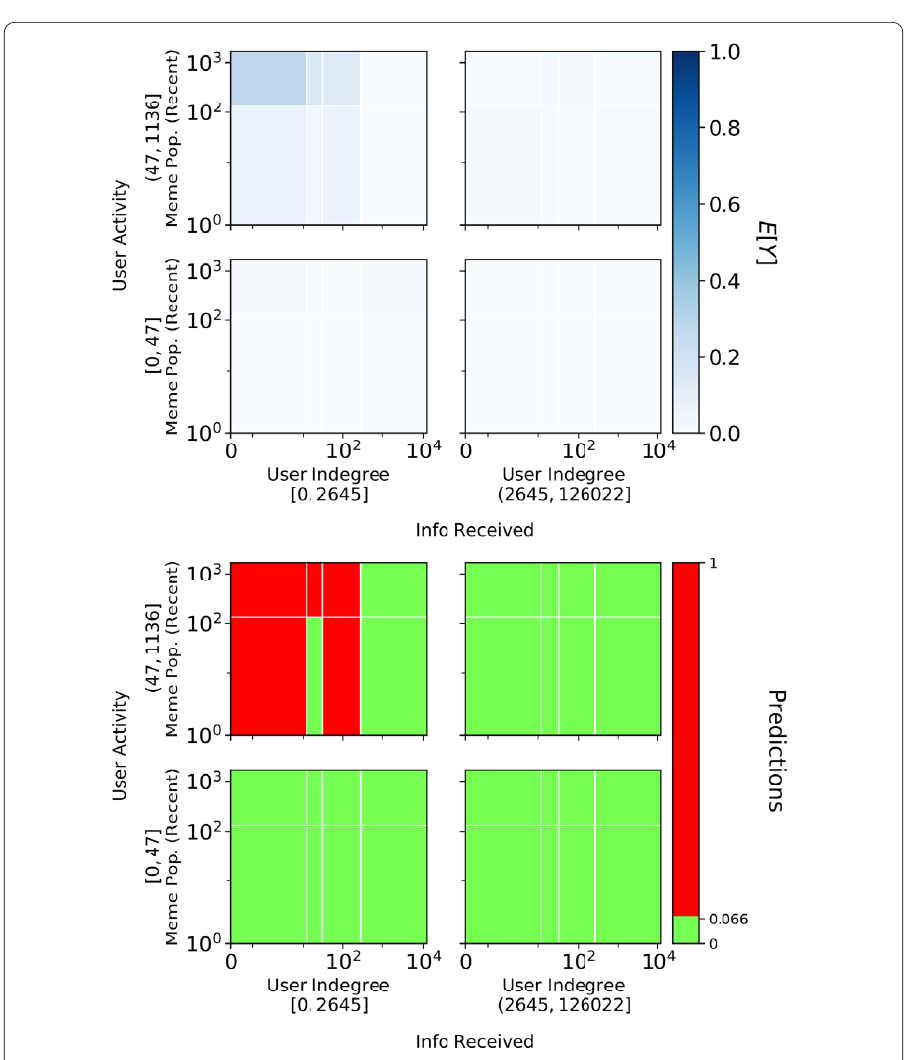
Figure 10 Visualization of the S3D model learned for Digg, showing the decomposition of feature space defined by four most important features. Each plot shows adoption probability of a meme within each block in the 3D feature subspace. Each bottom plot shows predicted meme adoptions. Gray areas have no observations